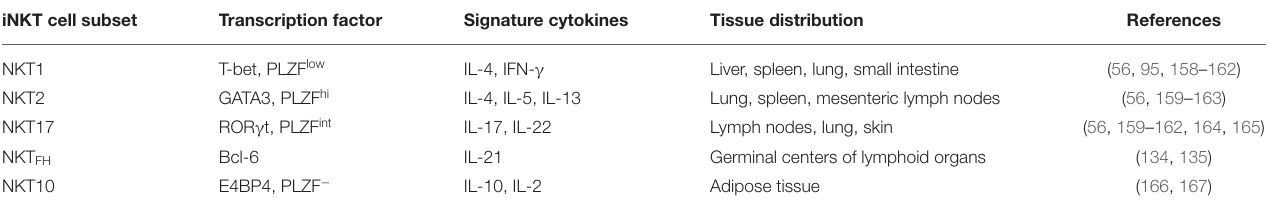
TABLE 2 | Key characteristics of the main invariant natural killer T (iNKT) cell subsets. iNKT cell